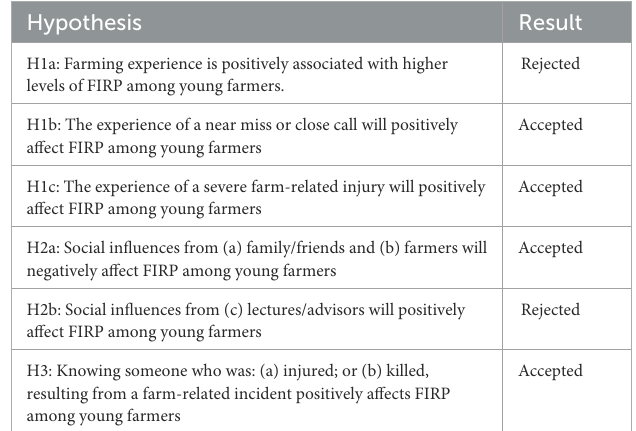
TABLE 6 Summary of hypothesis